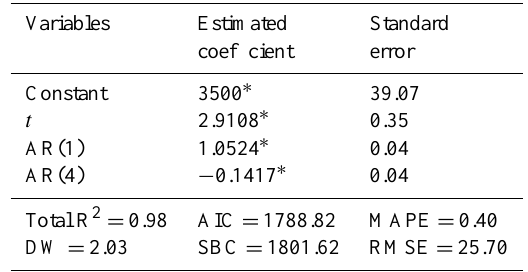
Table 2. Results of autoregressive error model to fit the pre-disaster time